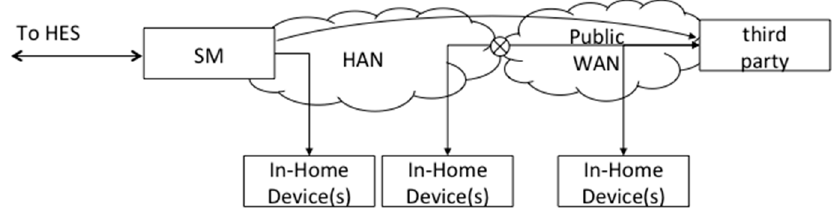
Figure 4. Architecture 2: the SM makes the data available to the consumer Home Area Network (HAN).